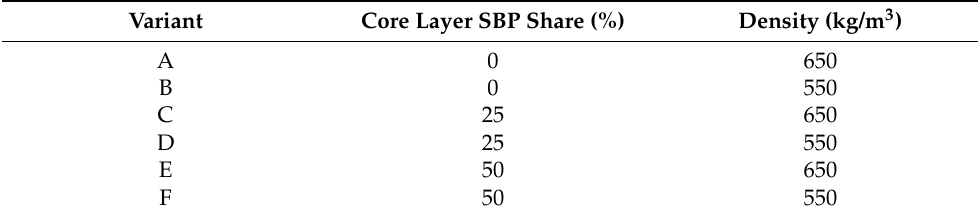
Table 1. Variants of manufactured